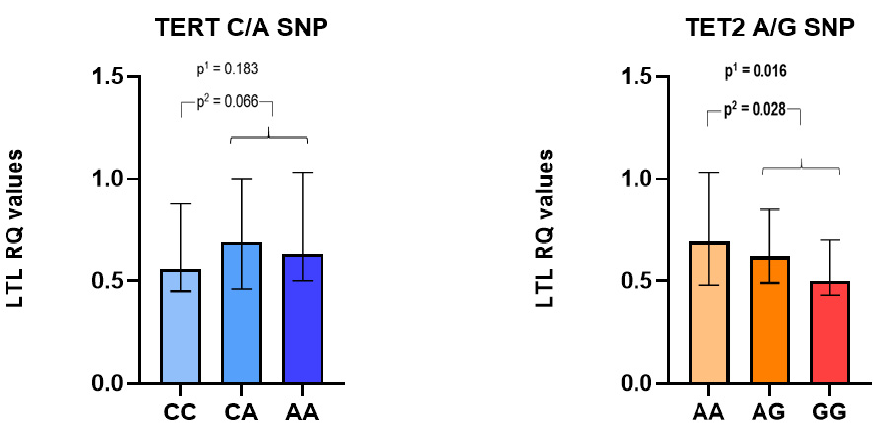
Figure 2. Relatively quantified (RQ) leukocyte telomere length (LTL), related to TERT rs7705526 (C/A) and TET2 rs2454206 (A/G) genotypes. p 1 values refer to the difference in LTLs between genotypes, whereas p 2 values refer to differences in LTLs between the presence of the variant allele compared to the wild type. In this subset, LTLs were not associated with MACE ( n = 34), independent of TERT and TET2 genotypes (median RQ level (25, 75 percentiles): 0.67 (0.51, 0.91) as compared to without MACE ( n = 228): 0.61 (0.46, 0.96)).